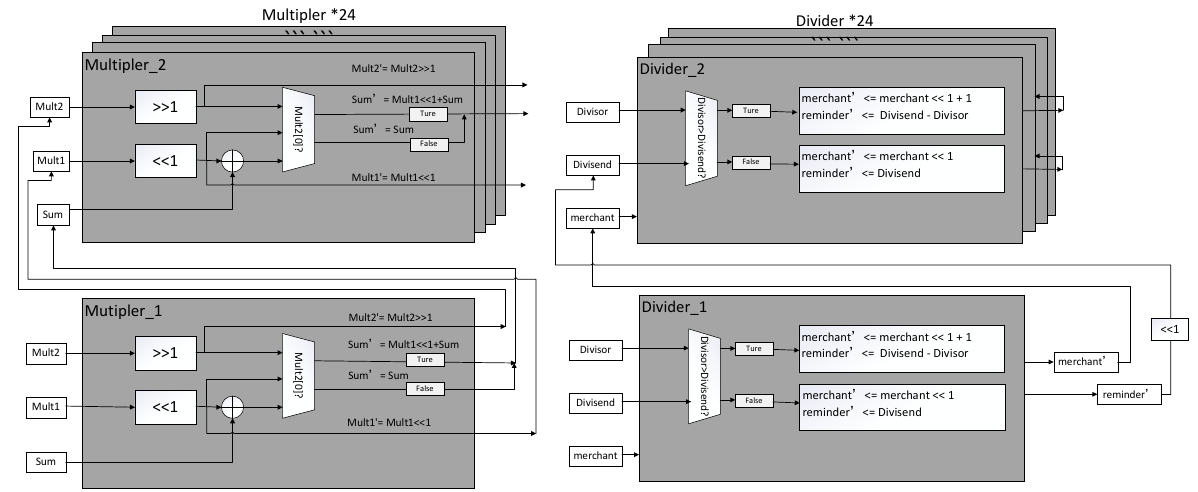
Figure 13. The floating-point operation consists of division and multiplier .